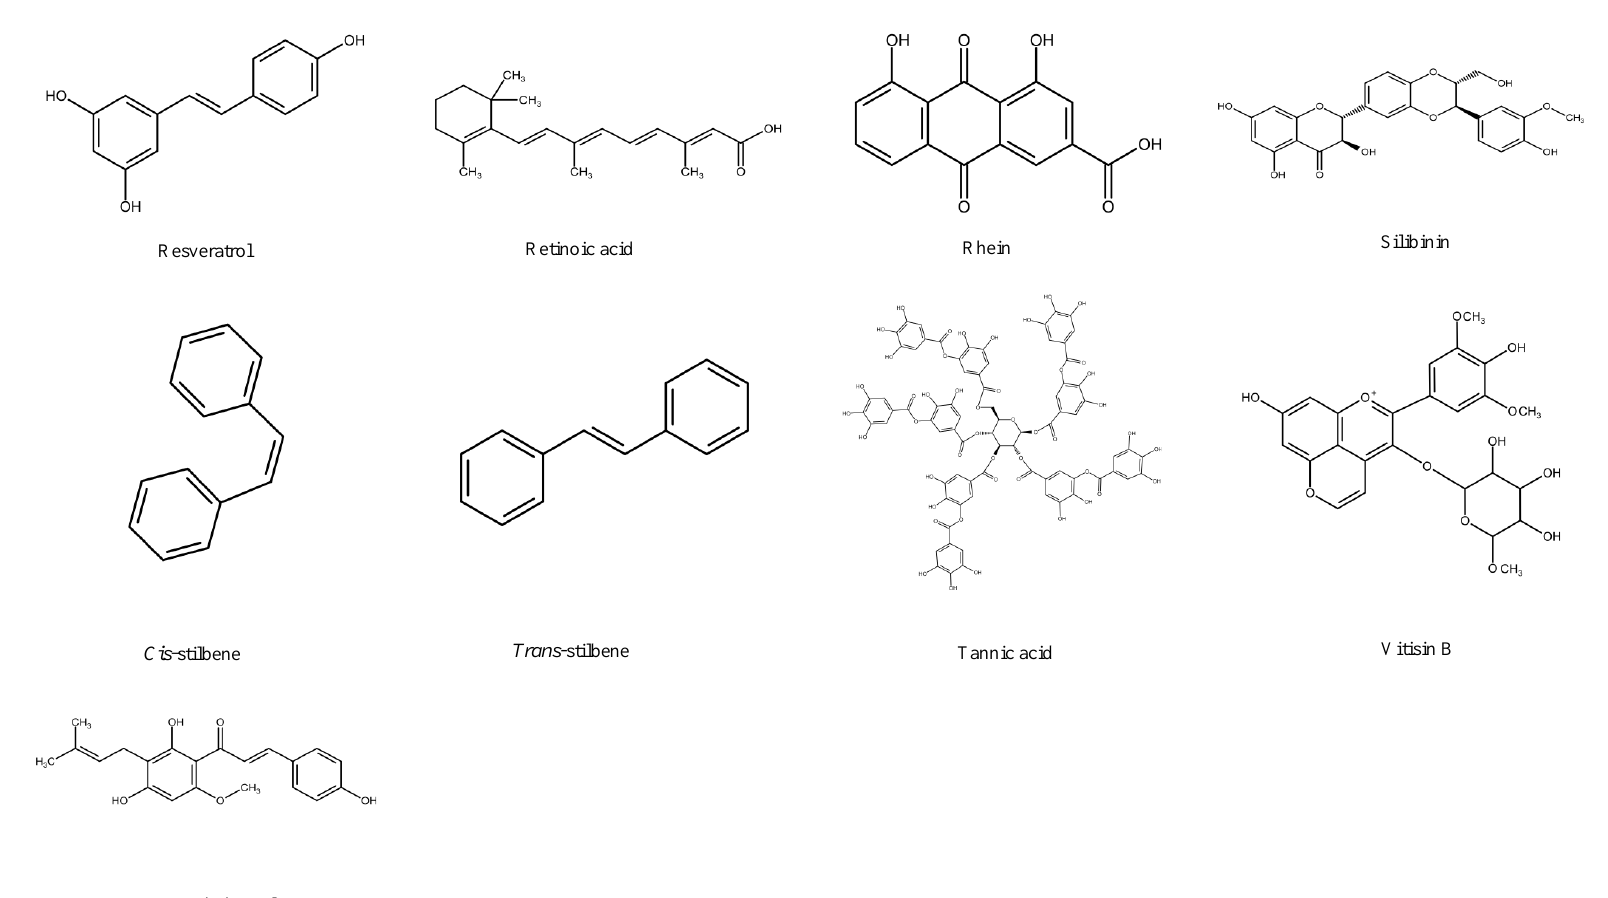
Figure 1. Chemical structures of all polyphenols discussed within this review. Aloe-emodin [29], Apigenin [30], Bestatin [31], Butein [32], Carnosic acid [33], Catechin [34], Chrysin [35], Curcumin [36], Delphinidin [37], Epigallocatechin gallate [38], Ellagic acid [39], Emodin [40], Epicatechin [41], Epsilon-viniferin [42], Flavopiridol [43], Gallic acid [44], Genistein [45], Guggulsterone [46], Icariside II [47], Luteolin [48], Piceatannol [49], Pinosylvin [50], Punicalagin [51], Quercetin [50], Resveratrol [52], Retinoic acid [53], Rhein [54], Silibinin [55], Cis -Stilbene [56], Trans -Stilbene [50], Tannic acid [57], Vitisin B [58], Xanthohumol